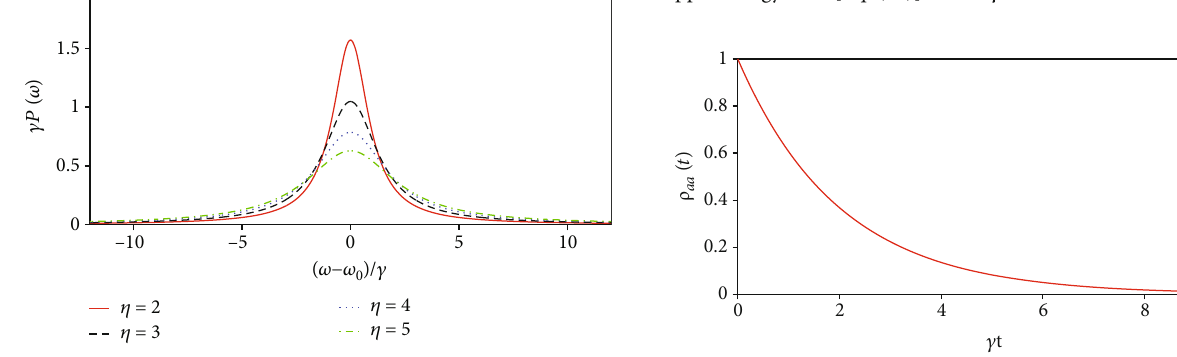
Figure 3: Plots of the probability for the two-level atom to be on the upper energy level [Eq. (55)] versus γ t .